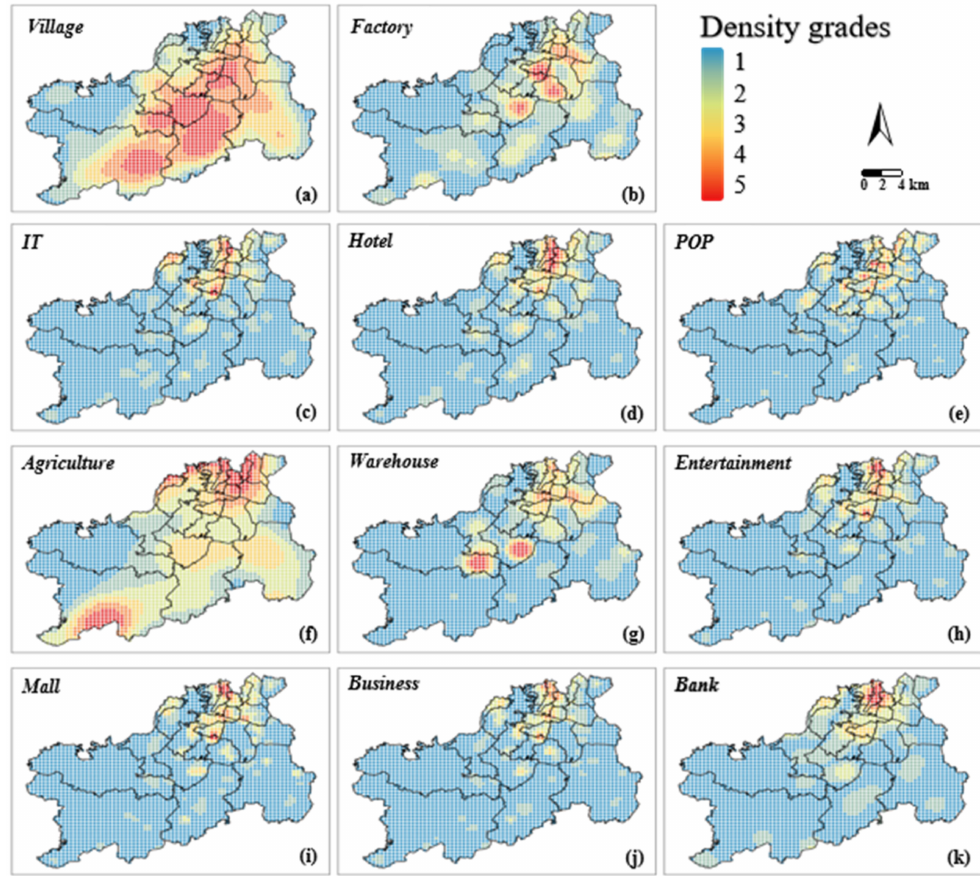
Figure 3. Spatial distribution of potential factors: ( a ) urban village area; ( b ) density of factories; ( c ) density of IT companies; ( d ) density of hotels; ( e ) population density; ( f ) density of agriculture POIs; ( g ) density of warehouses; ( h ) density of entertainment places, including KTVs, net bars, and massage parlors; ( i ) density of shopping malls and stores; ( j ) density of business-leasing service POIs; ( k ) density of